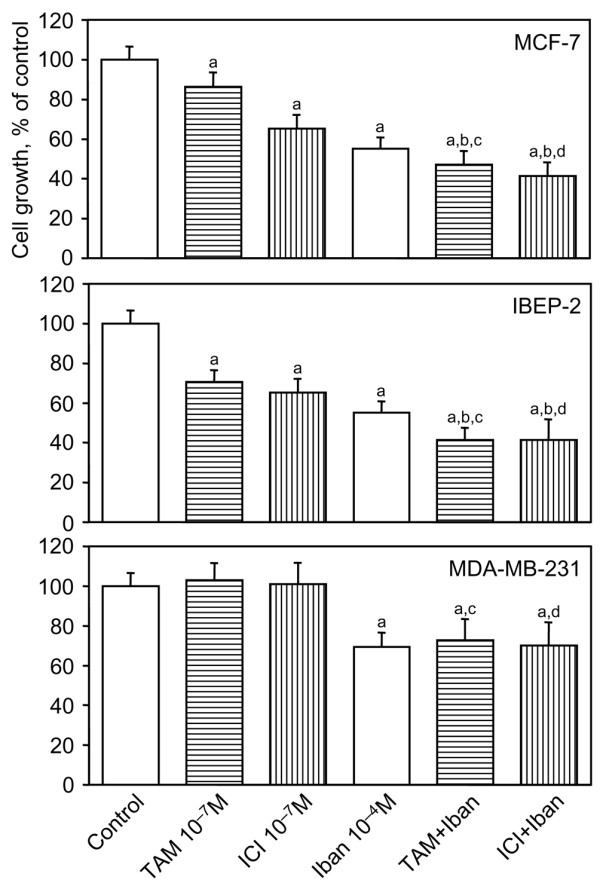
Effect of combined treatment of MCF-7, IBEP-2 and MDA-MB-231 cells with ibandronate (Iban) and 4-hydroxytamoxifen (TAM) or ICI 182,780 (ICI). Cells were incubated with 10-4 M Iban in the presence or absence of 10-7 M TAM or ICI for 72 hours. Cell proliferation was determined as described in Fig. 1. ANOVA, p < 0.01: a, significantly different from control; b, significantly different from Iban alone; c, significantly different from TAM alone; d, significantly different from ICI alone; Tukey post hoc test.